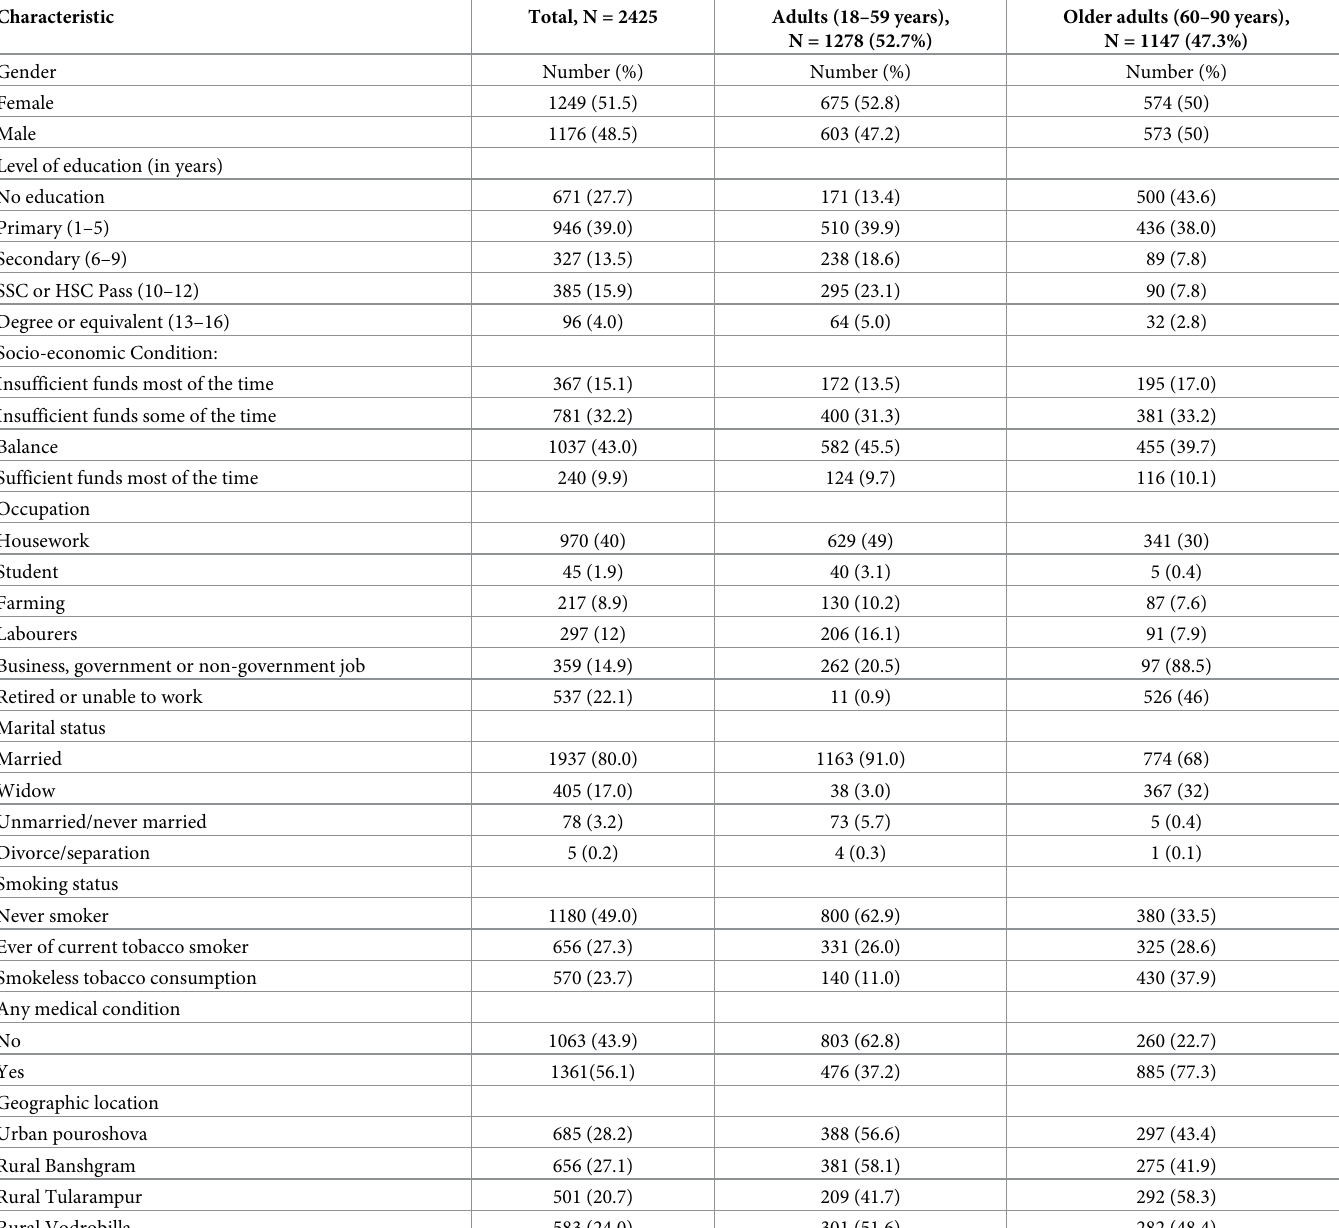
Table 1. Sociodemographic characteristic of adults and older adults in a rural district in Bangladesh.